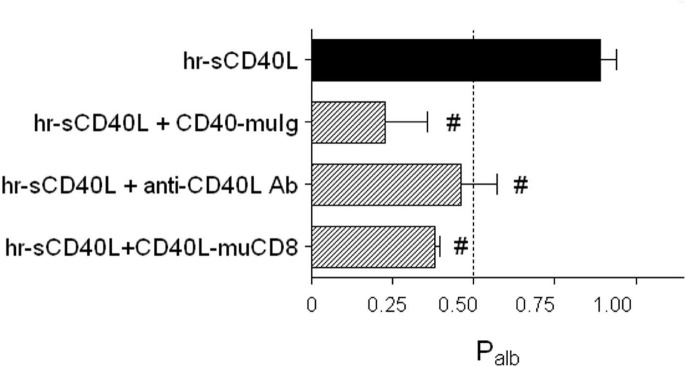
Permeability activity of albumin (Palb) induced by sCD40L in isolated rat glomeruli.Palb was determined after the incubation of rat glomeruli for 30 min with hr-sCD40L (100 ng/ml + 1 μg/ml enhancer). A significant increase in glomerular permeability is expressed by values of Palb greater than 0.5 (black bar). Using CD40-muIg fusion protein (20 ng/ml) and the neutralizing antibody against CD40L (5 μg/ml), hr-sCD40L was pre-treated for 10 minutes prior to glomerulus stimulation, whereas the CD40L-muCD8 fusion protein (50 ng/ml) was added to the glomeruli 30 minutes before adding hr-sCD40L (dashed bars) (see Methods for details). At least five animals were studied per each experimental group. *P < 0.05 and **P < 0.01 versus unstimulated controls; #P < 0.01 versus rh-sCD40L.